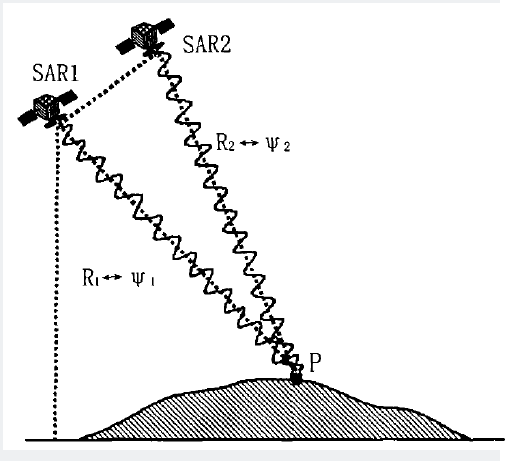
Figure 1 Basicprinciple diagram of